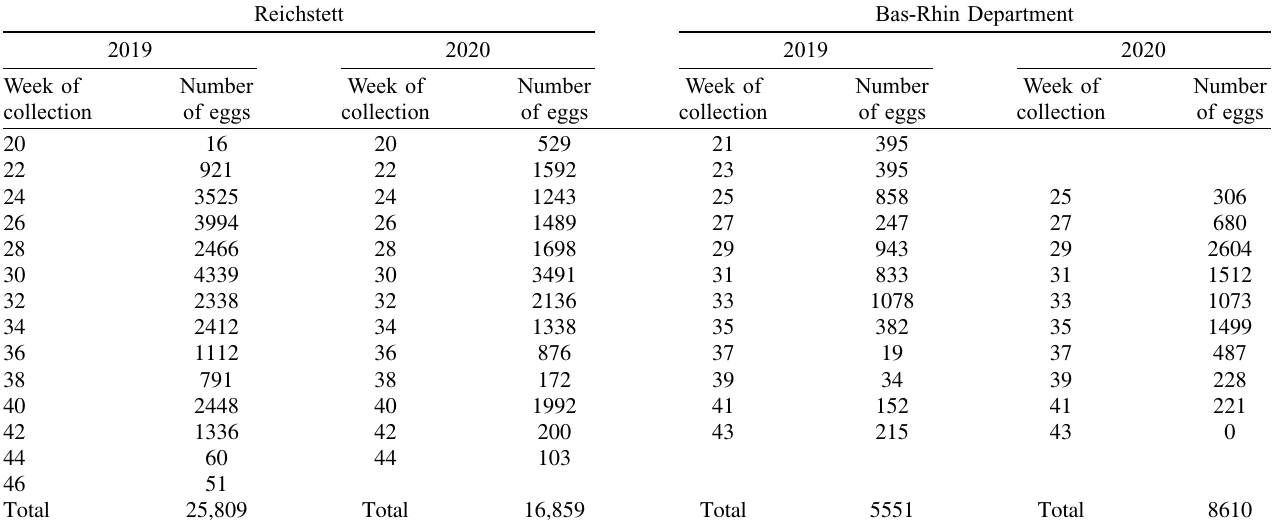
Table 1. Number of eggs of Ae. japonicus collected in Reichstett and in the Bas-Rhin Department. The data from 12 ovitraps for Reichstett and from 158 ovitraps for 2019 to 98 ovitraps for 2020 for the Bas-Rhin Department are summed up per